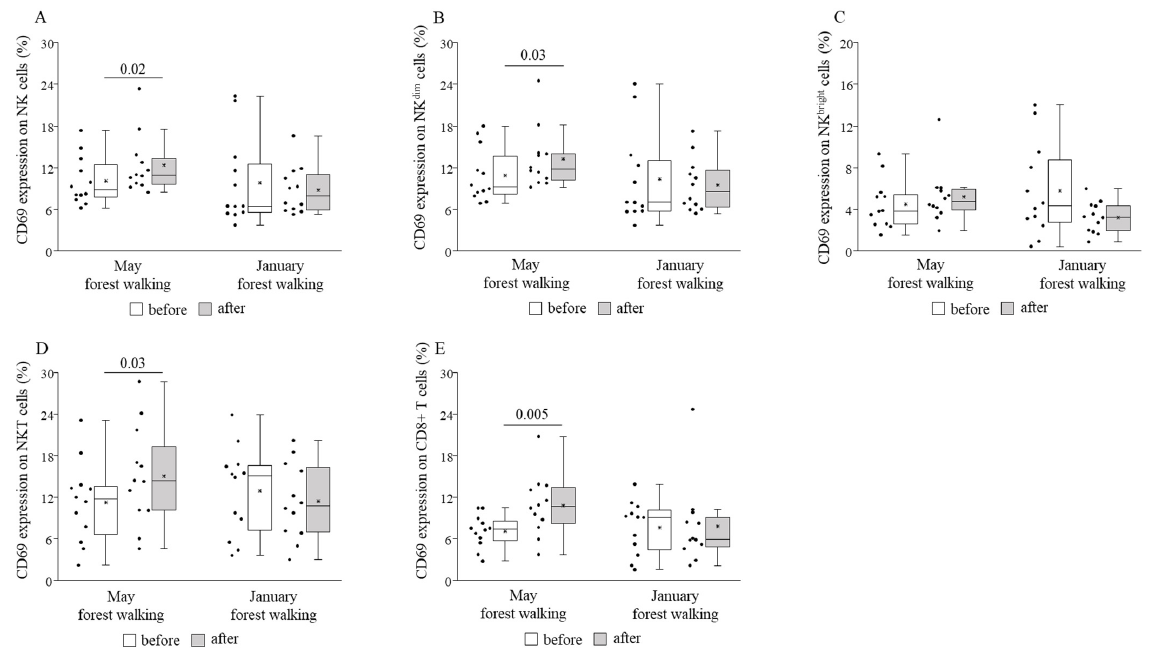
Figure 4. CD69 expressions on total natural killer (NK) ( A ), NK dim ( B ), NK bright ( C ), NKT ( D ), and CD8+ T ( E ) cells prior to and following the late spring (May) and winter (January) forest walks. The middle line within the box represents the median, the middle dot within the box represents the mean, the boxes indicate the interquartile ranges between the 25th and 75th percentiles, and the whiskers show the most extreme observations in the box plot. Individual dots left from the boxes represent individual data values. Differences were considered statistically significant for p -values < 0.05. Statistically significant p -values are indicated on the horizontal lines outside the boxes. NKG2D expression was revealed to be raised on NK bright and NKT cells after the late spring session and on total NK and NK dim cells after the winter session without any change on any other cell subsets in either season (Figure 5).